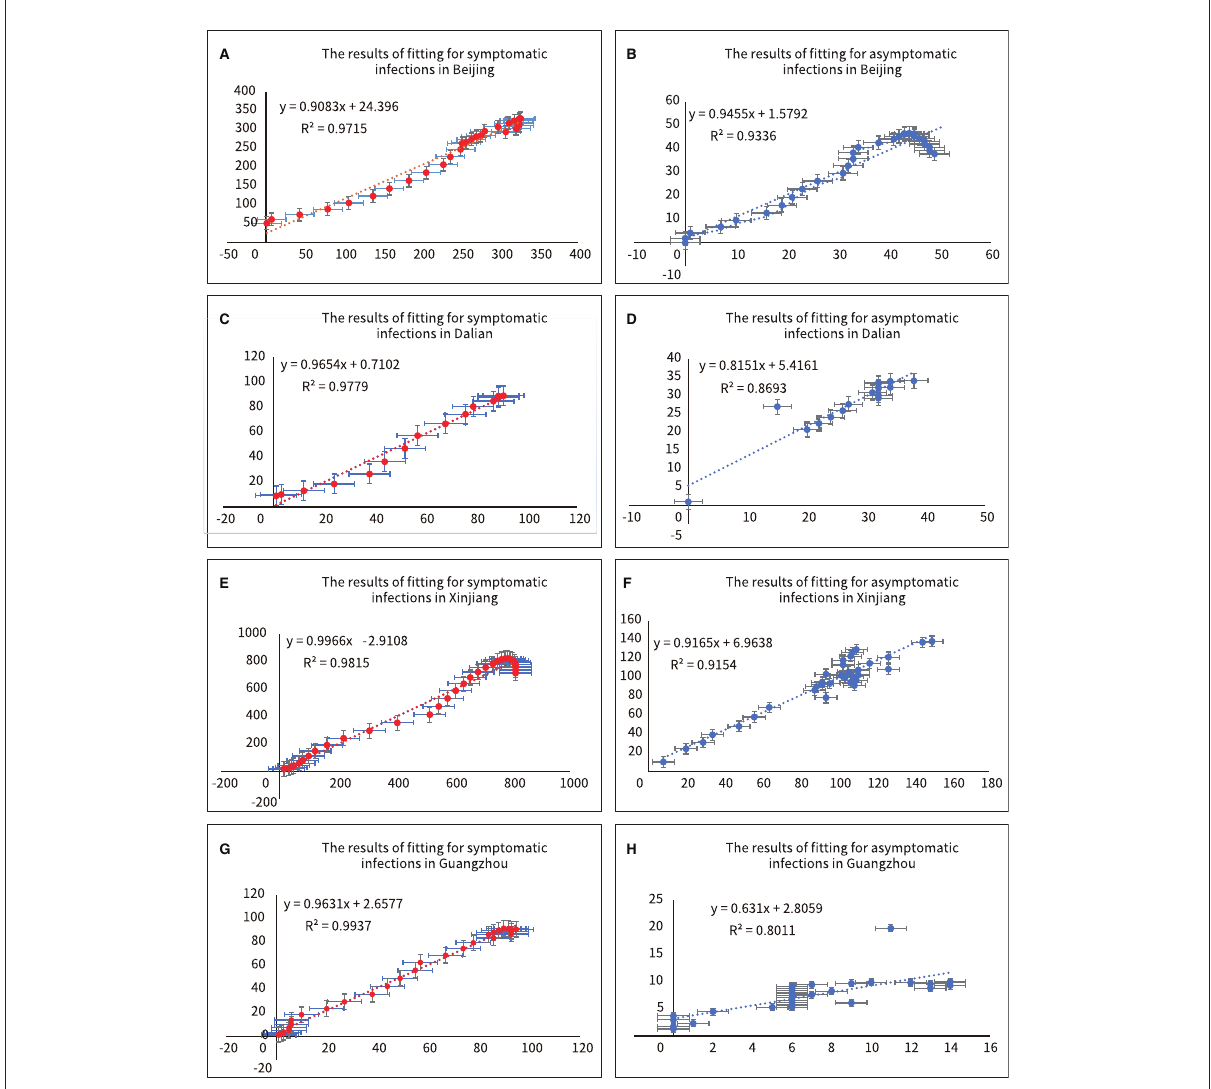
FIGURE6 Analyzing of fitting for symptomatic and asymptomatic infections in four outbreaks. (A) R ² of symptomatic infections in Beijing, (B) R ² of asymptomatic infections in Beijing, (C) R ² of symptomatic infections in Dalian, (D) R ² of asymptomatic infections in Dalian, (E) R ² of symptomatic infections in Xinjiang, (F) R ² of asymptomatic infections in Xinjiang, (G) R ² of symptomatic infections in Guangzhou, (H) R ² of asymptomatic infections in